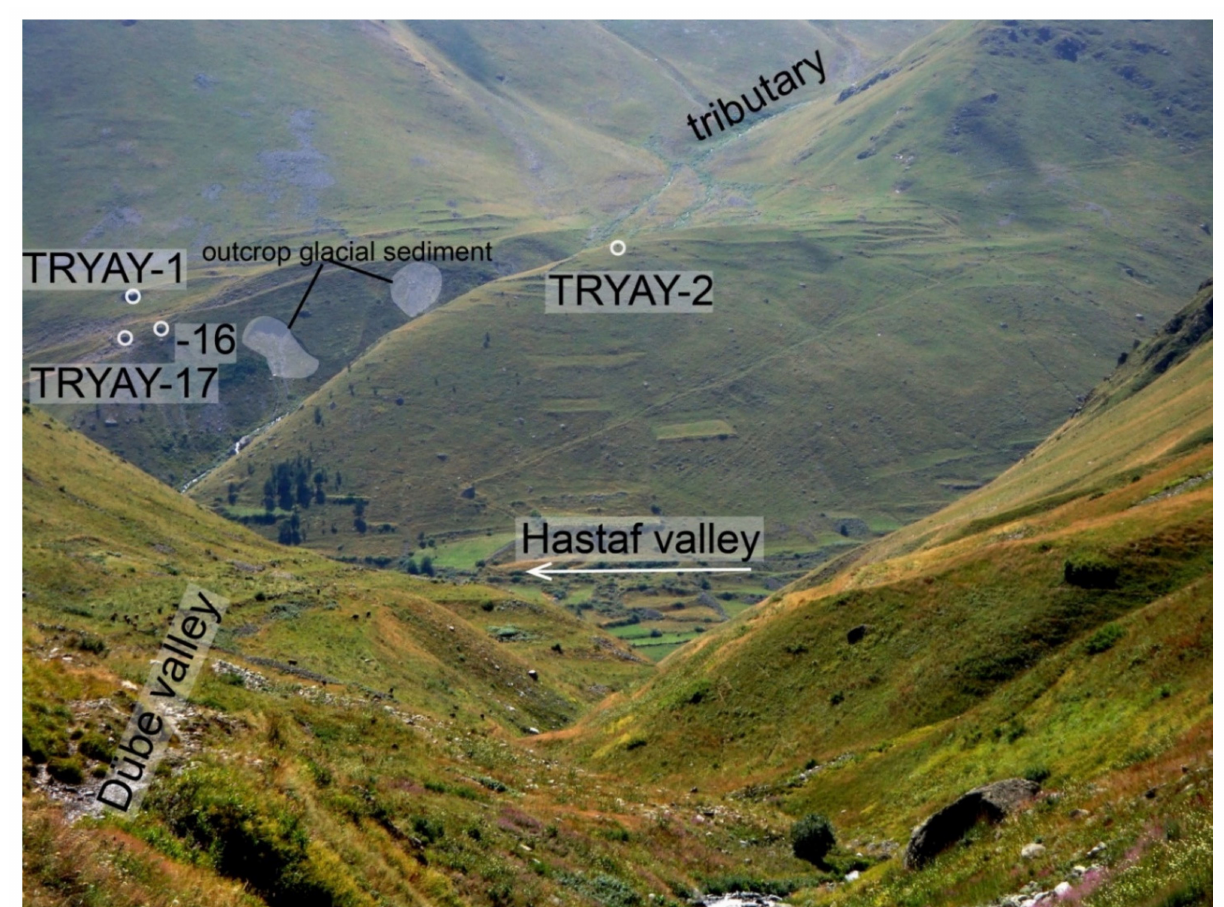
Figure 8. Ice contact morphologies at confluence of Dübe and Hastaf Valleys with sample and glacial sediment